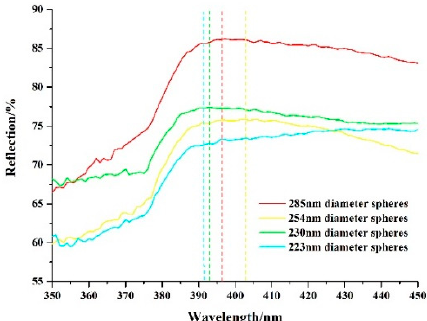
Figure 10. UV-Vis spectra of spheres of different diameters.